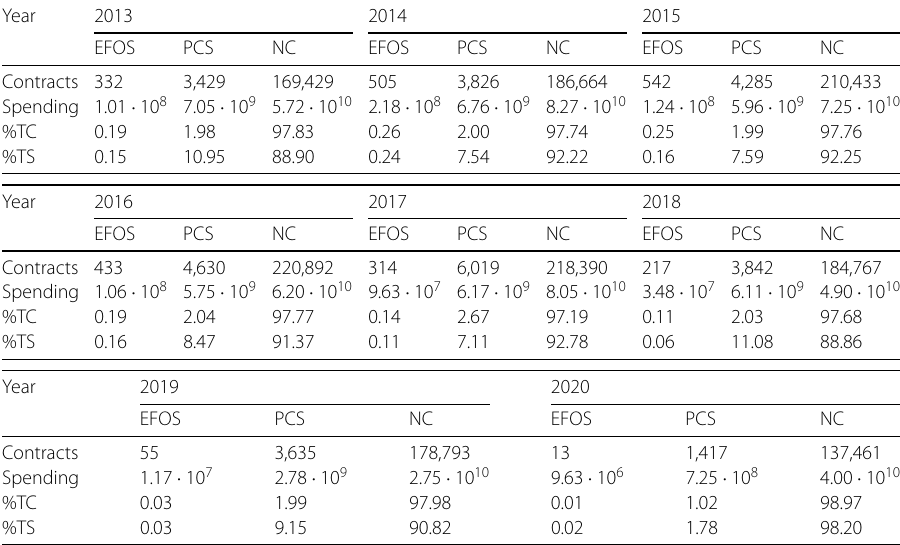
Table 4 Data for each contract class per year in the period 2013-2020. Number of contracts, spending (indicated in USD PPP), percentage of total contracts (%TC) and percentage of total spending (%TS) made in each contract class. This data were extract from the source